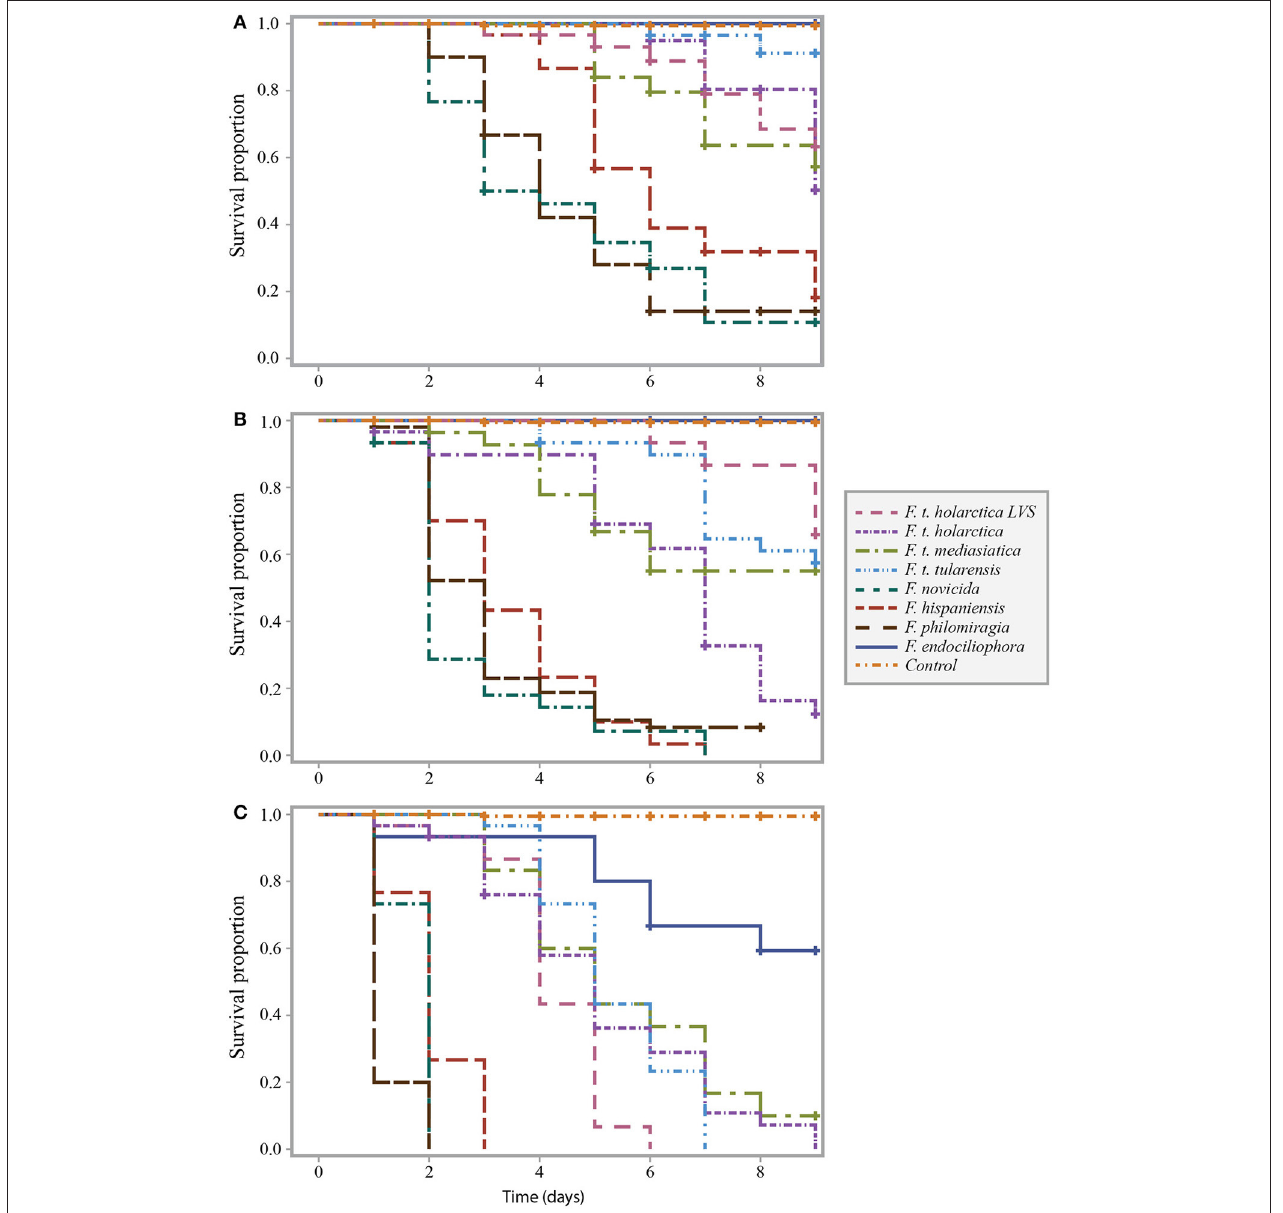
FIGURE 1 | Survival curve comparison of G. mellonella infected with F. t. tularensis, F. t. holarctica, F. t. mediasiatica, F. novicida, F. hispaniensis, F. philomiragia , and F. endociliophora at a temperature of 37 ◦ C with an infectious dose of (A) 10 4 bacteria/mL, (B) 10 6 bacteria/mL, and (C) 10 8 bacteria/mL. Experiments were performed in three separate runs with ten larvae in each run for each treatment. Censored observations are indicated with a plus sign ( + ).